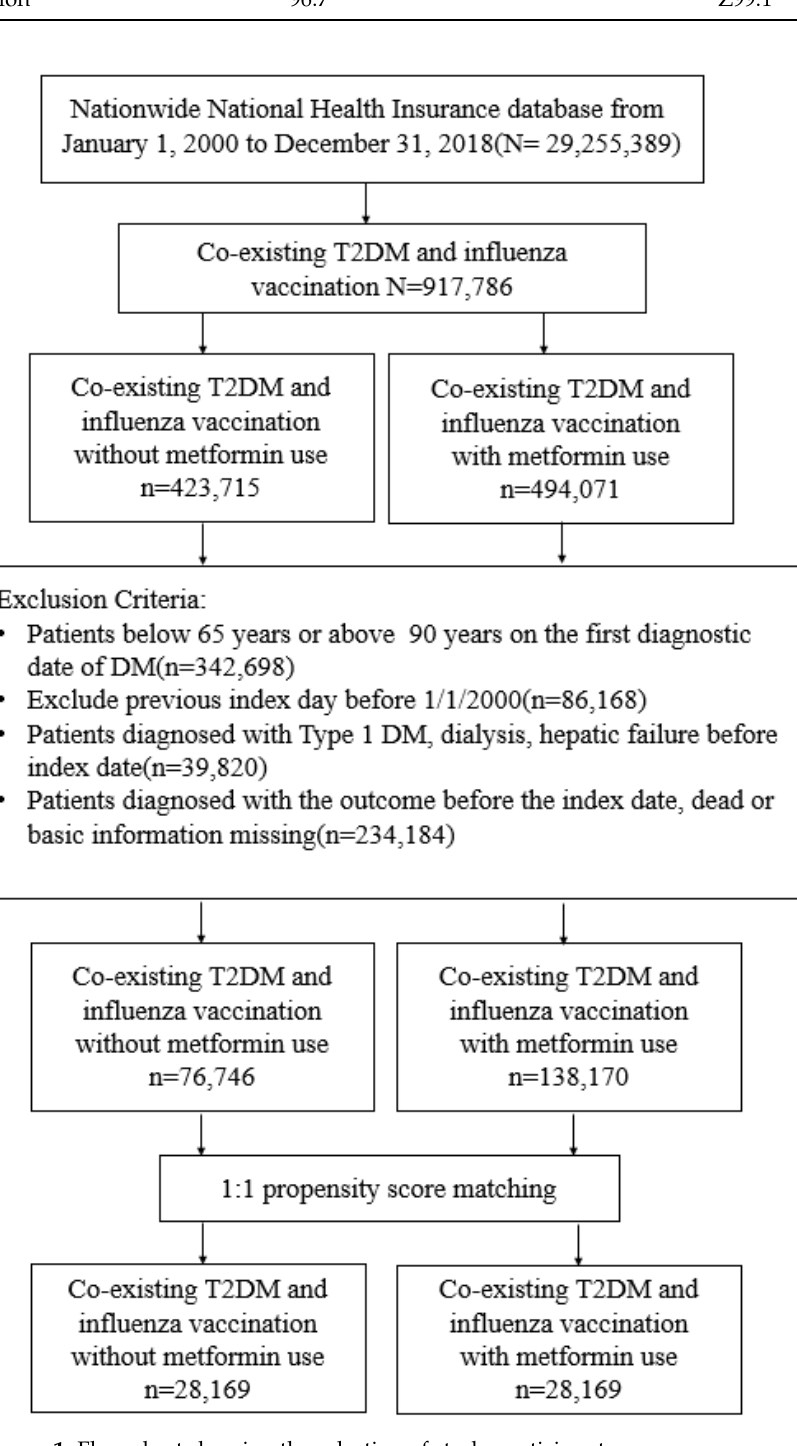
Figure 1. Flow chart showing the selection of study participants.